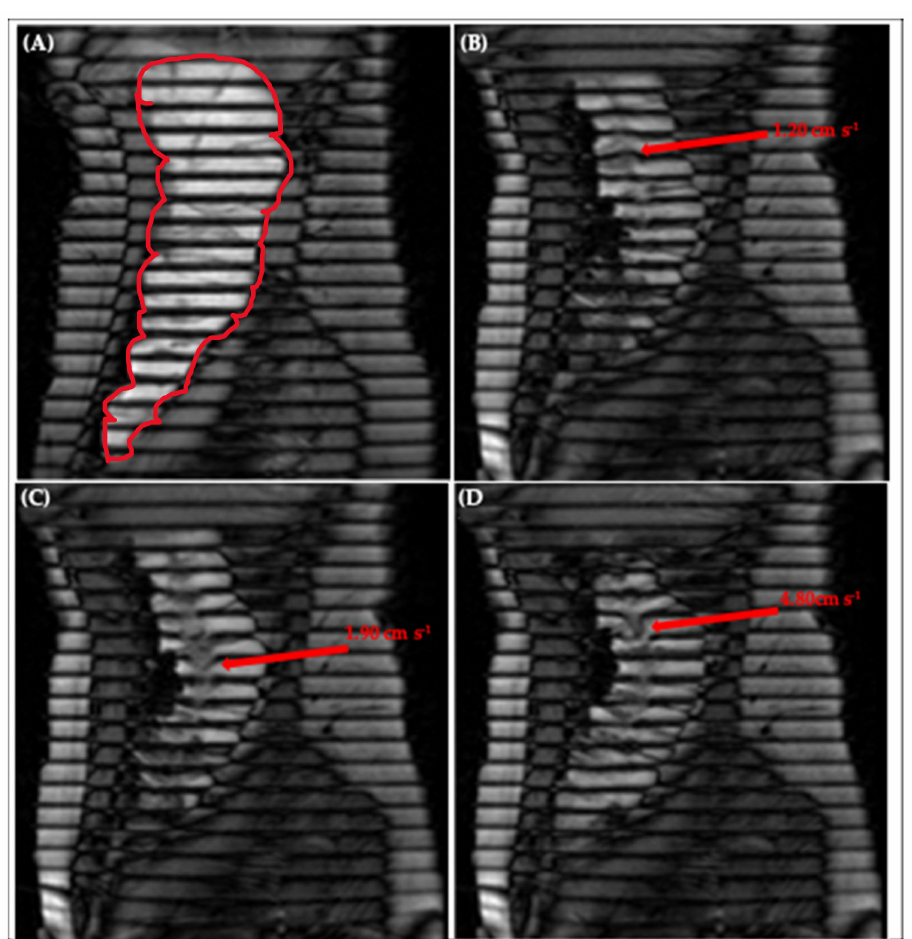
Figure 6. Tagging applied to the ascending colon, outlined in red in ( A ), showing ( A ) little mo- tion, ( B ) antegrade flow of 1.20 ± 0.20 cm · s − 1 close to the hepatic flexure, ( C ) retrograde flow of 1.90 ± 0.20 cm · s − 1 close to the midpoint of the AC and ( D ) retrograde ‘jet’ of 4.80 ± 0.20 cm · s − 1 close to the hepatic flexure. Images taken from supplementary video S2 of Pritchard et al.